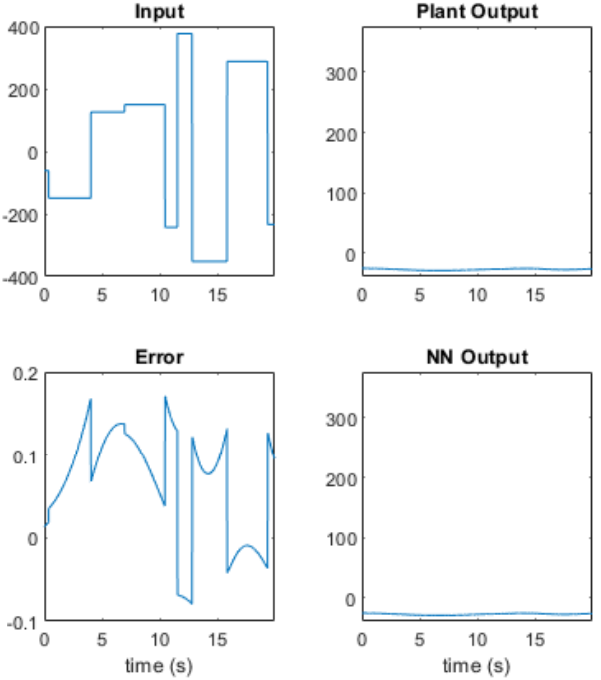
Figure 25. Neural model validation data.